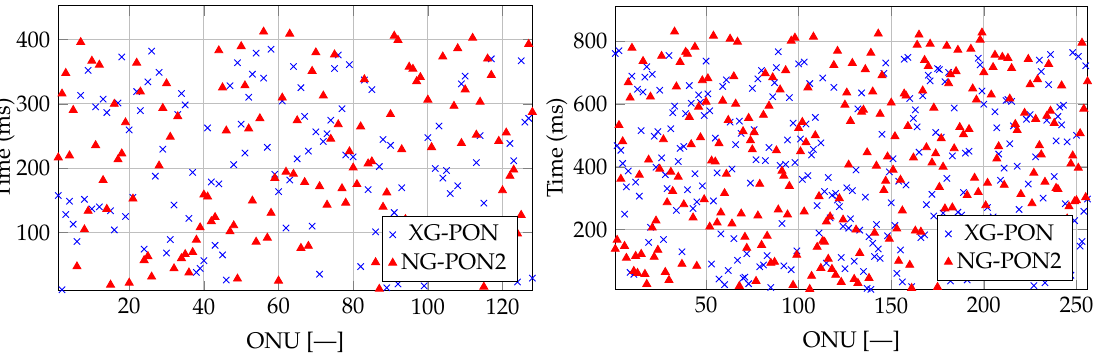
Figure 9. Graph of activation time for XG-PON and NG-PON2 with a 1:128 split ratio and 20-km length Figure 5. Graph of activation time for GPON 32/64 units and 20 km ODN. Figure 5. Graph of activation time for GPON 32/64 units and 20 km ODN. of ODN ( left ) and XG-PON and NG-PON2 with a 1:256 split ratio and a 20-km length of ODN ( right